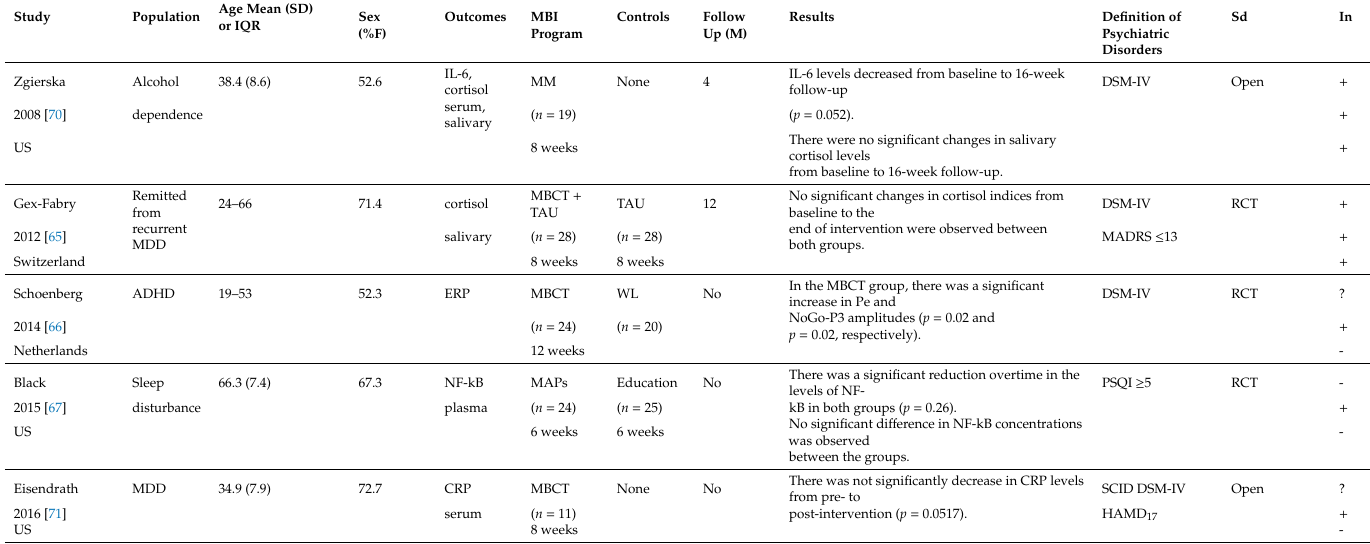
Table 3. Characteristics of studies included in the systematic